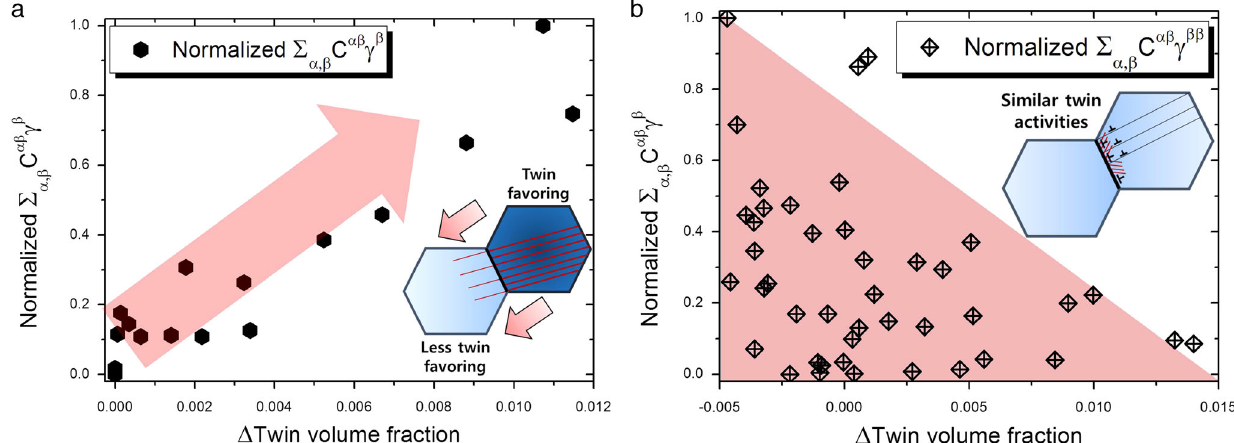
Fig. 9 Calculated inter-grain interaction coef fi cients against the difference between twin volume fraction of grain boundary and grain interior regions due to a strain transfer and b strain localization. The inset illustrates how a strain transfer and b strain localization affect twinning near grain boundaries